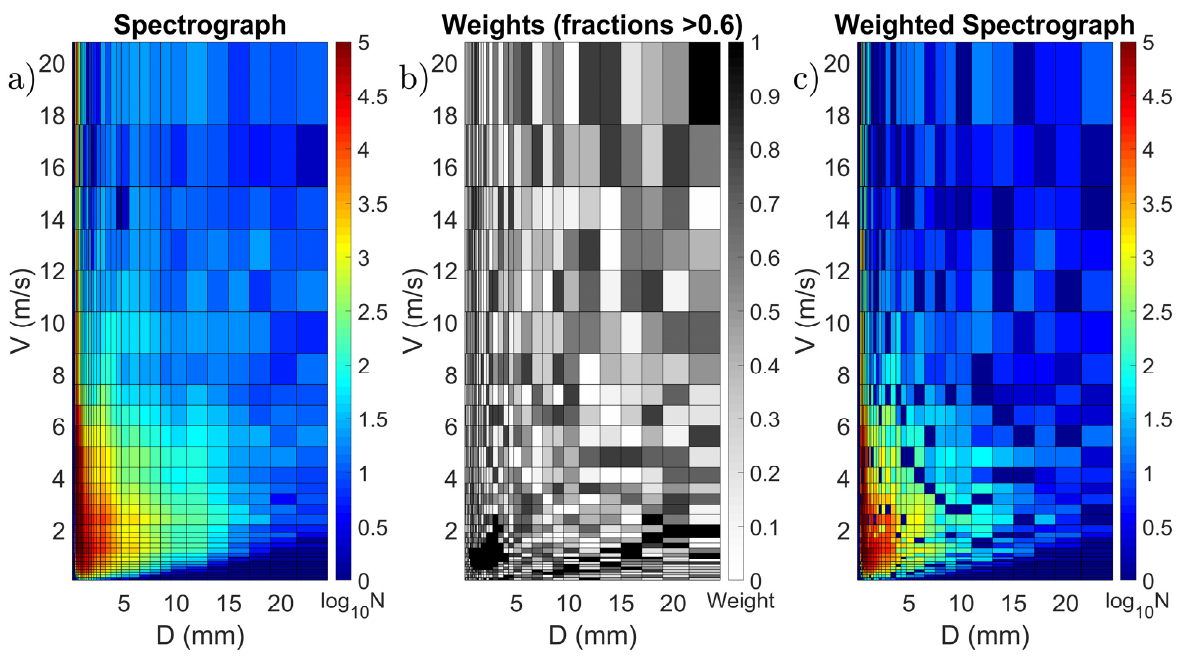
Figure 3. Application of the weighting method described in Section 2.5: ( a ) Original particle spec- trograph; ( b ) Selected weight mask for each disdrometer bin; ( c ) Resulting weighted disdrometer spectrograph.